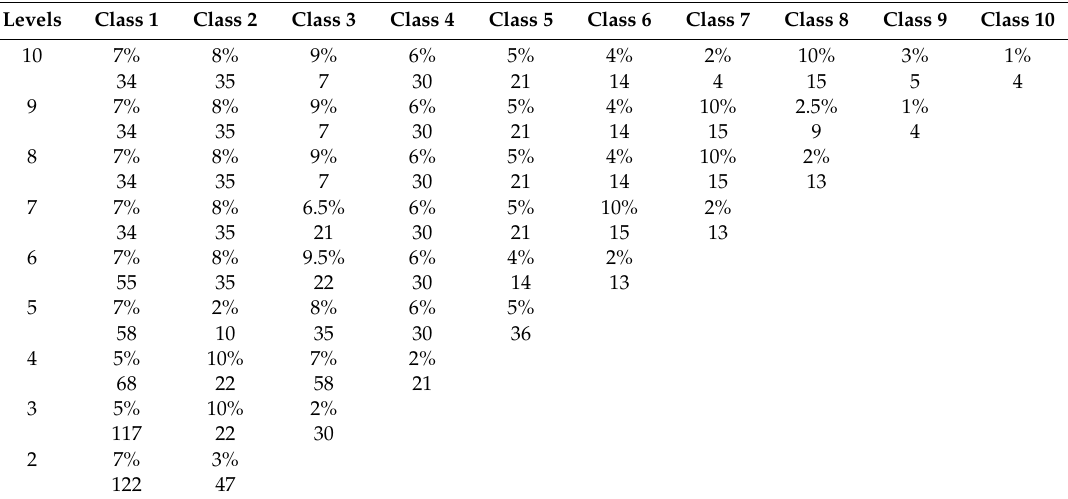
Table 7. Support value of each product